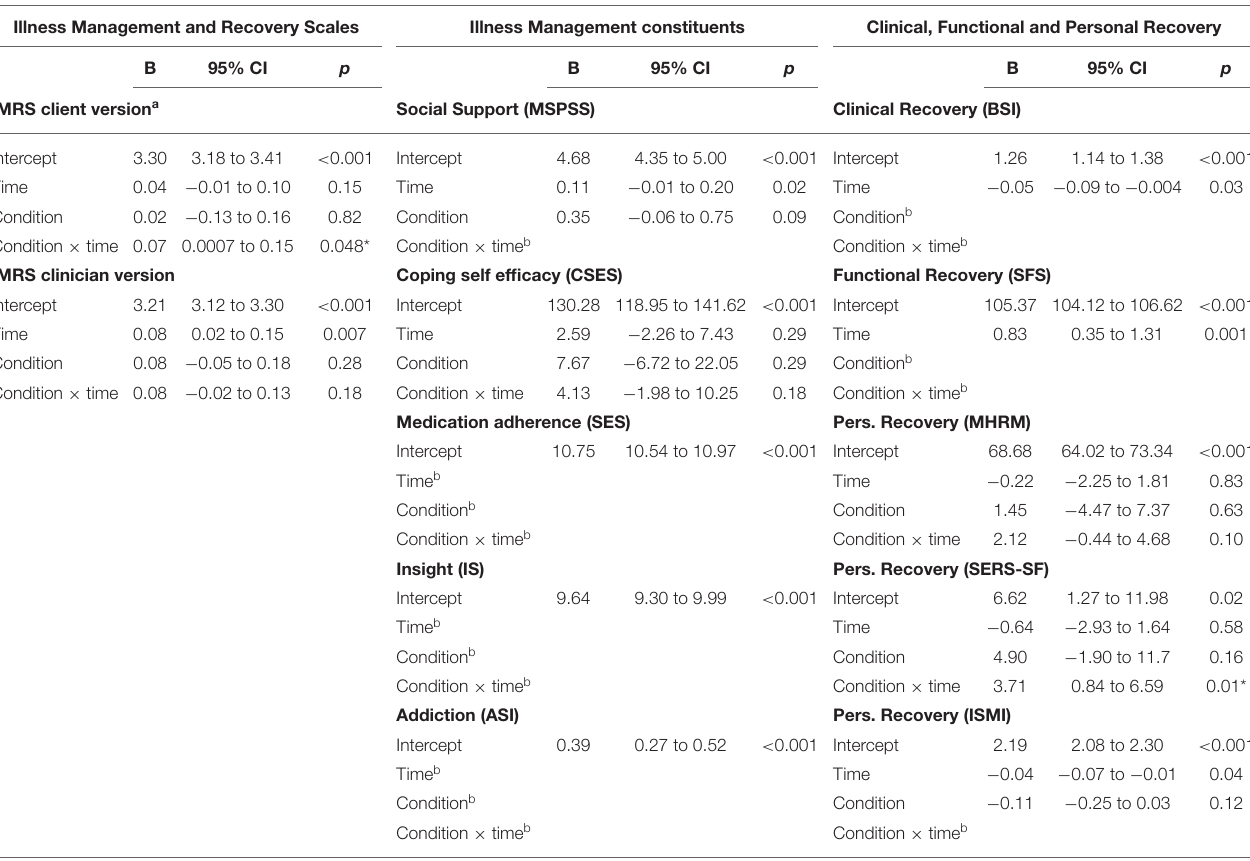
TABLE 2 | Fixed effects of IMR on all outcomes from final linear mixed model, in the Intention to treat sample. Illness Management and Recovery